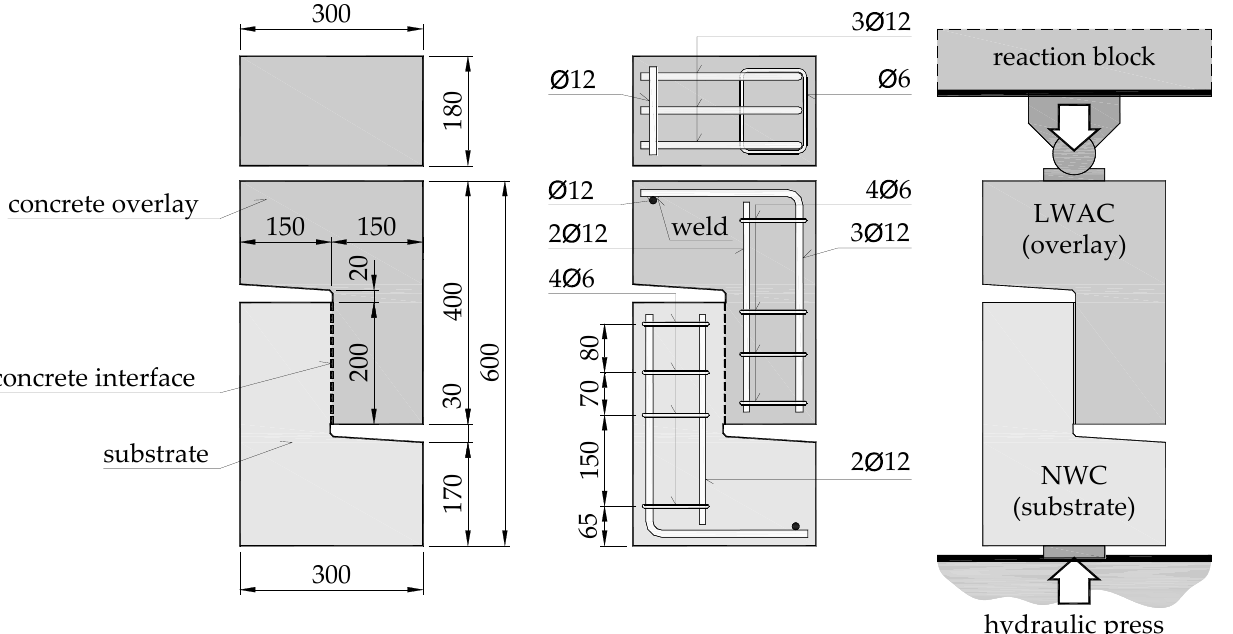
Figure 3. Details of the test specimens and the test setup (all dimensions in mm).